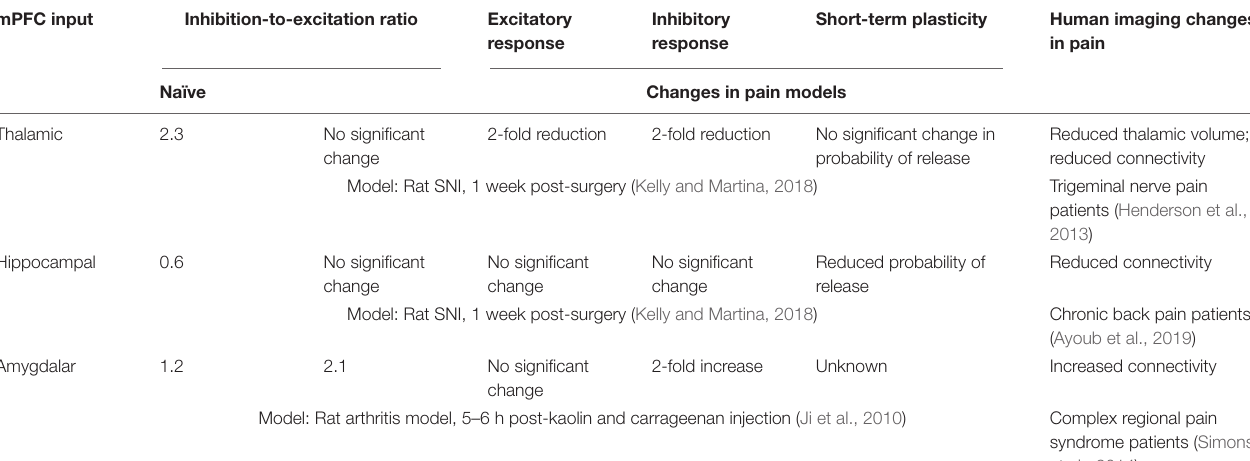
TABLE 1 | Main pain-associated alterations in mPFC glutamatergic